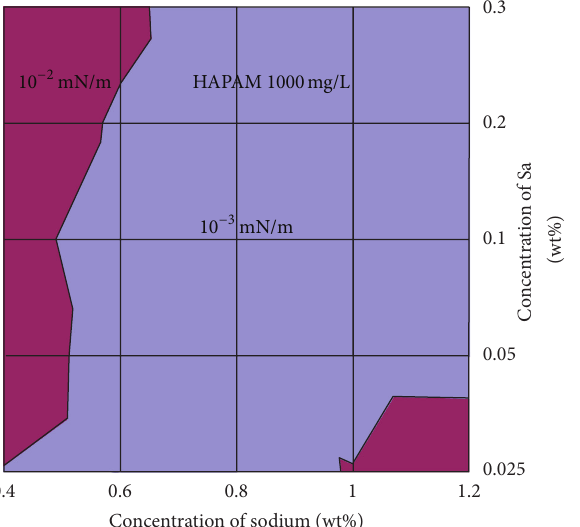
Figure 5: Dynamic interfacial tension of the two ASP systems.